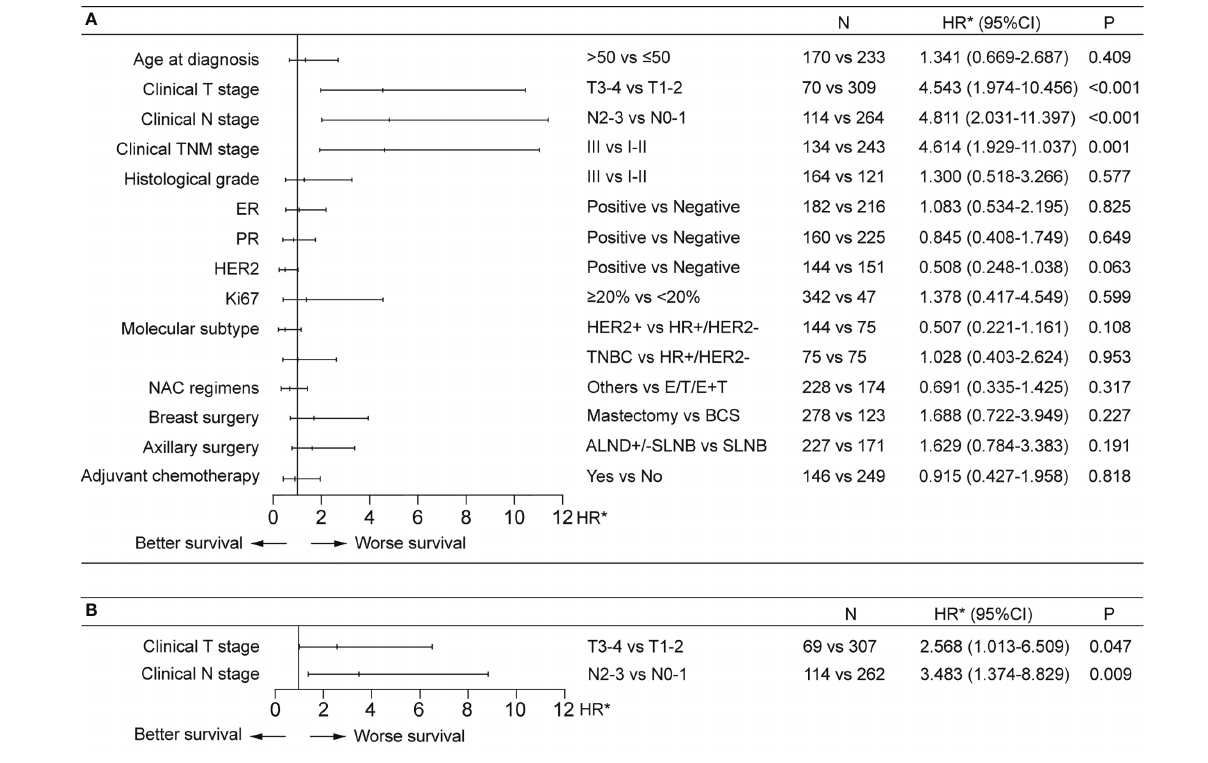
FIGURE 3 | Factors associated with recurrence-free survival (RFS) in univariable (A) and multivariable (B) Cox regression analysis in the pCR patients. (A) Higher pre-NAC clinical T and clinical N stages were associated with worse RFS in the univariable Cox regression analysis. (B) Higher pre-NAC clinical T and clinical N stages were independent prognostic factors for RFS. ALND, axillary lymph node dissection; BCS, breast-conserving surgery; CI, con fi dence interval; E, anthracycline; ER, estrogen receptor; HR, hormone receptor; HR*, hazard ratio; HER2, human epidermal growth factor receptor 2; NAC, neoadjuvant chemotherapy; PR, progesterone receptor; SLNB, sentinel lymph node biopsy; T, taxine; TNBC, triple-negative breast